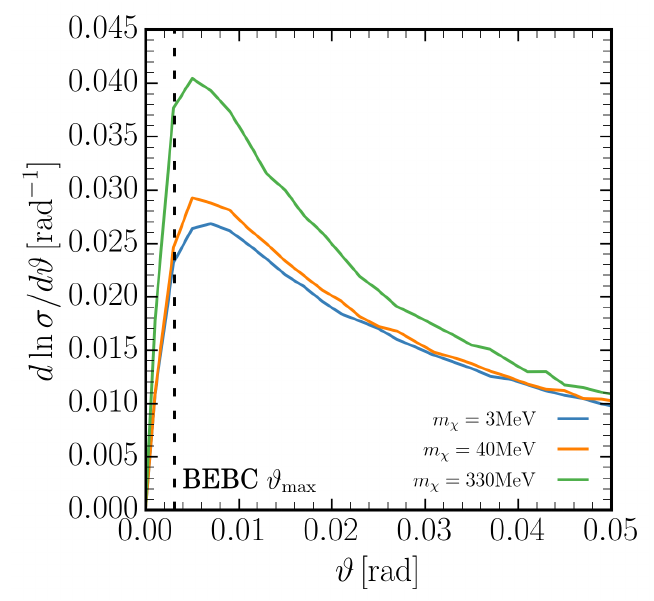
Figure 1: The differential angular distribution of dark states emerging from the beam